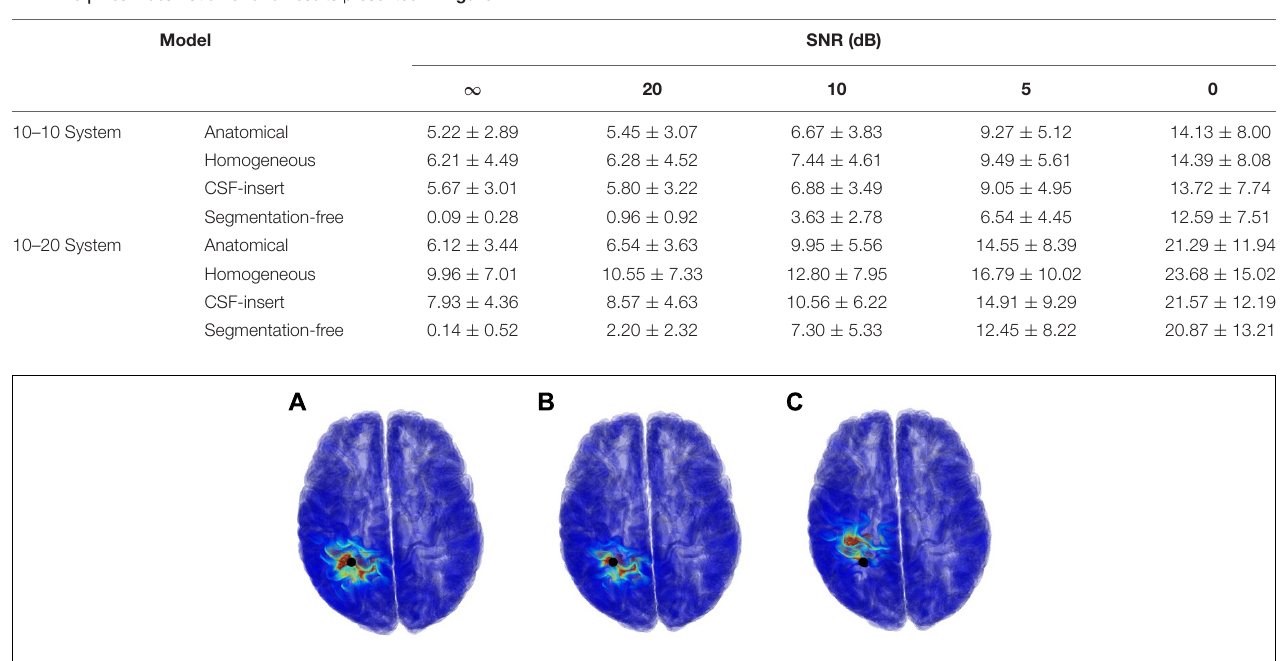
TABLE 6 | Mean localization error of results presented in Figure 7 .